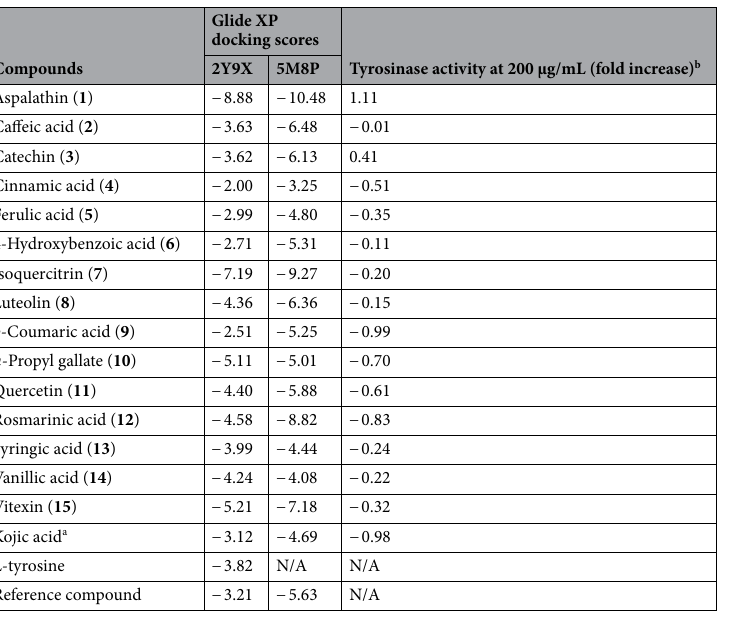
Table 4. Docking scores of the compounds using the 2Y9X tyrosinase structures and 5M8P tyrosinase related protein 1 and the mushroom tyrosinase activity (%) of the compounds at a concentration of 200 µg/mL. a Positive control for the tyrosinase assay b Determined as the enzyme rate of the sample divided by the enzyme rate of the vehicle control; the fold increase values of the samples were recorded at 200 µg/mL. The enzyme rate was kinetically determined over a period of 30 min at 37 °C.